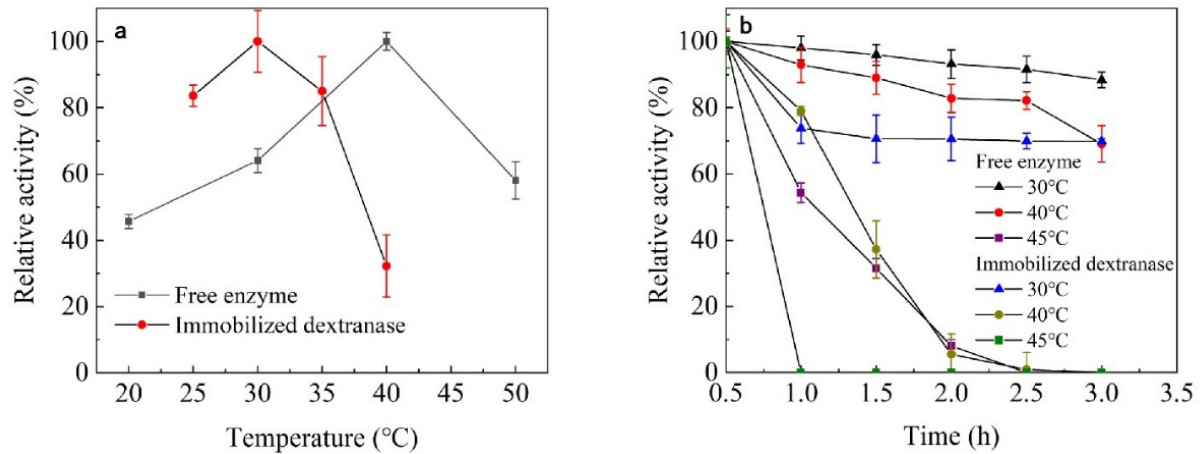
Figure 3. ( a ) Optimum temperature, and ( b ) temperature stability.